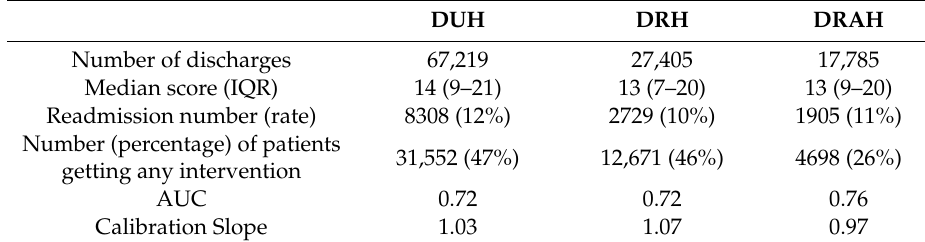
Table 1. Characteristics in Encounter-Level from 01 / 01 / 2018–12 / 31 / 2019.